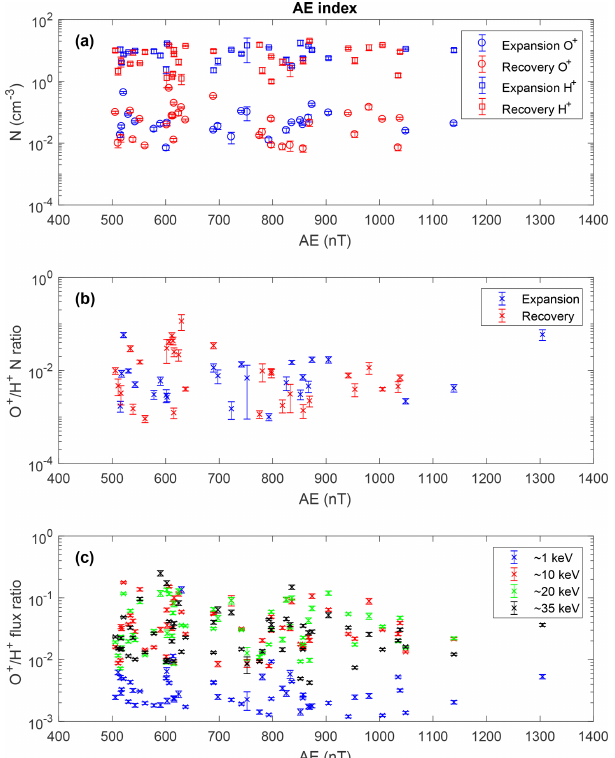
Figure 5. The relationship between the energetic O + at the duskside magnetopause and IMF B y during intense substorms. The format is the same as that of Fig.